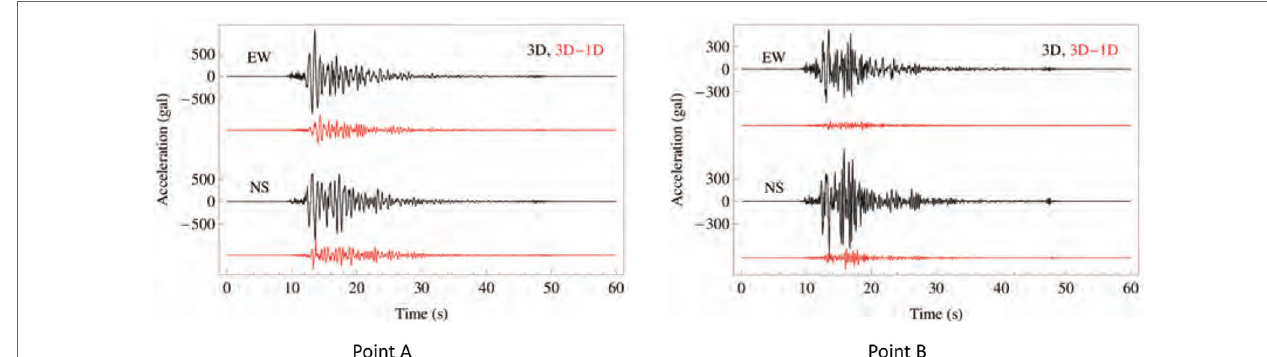
FigUre 8 | Comparison of ground motion simulation and conventional 1D analysis.